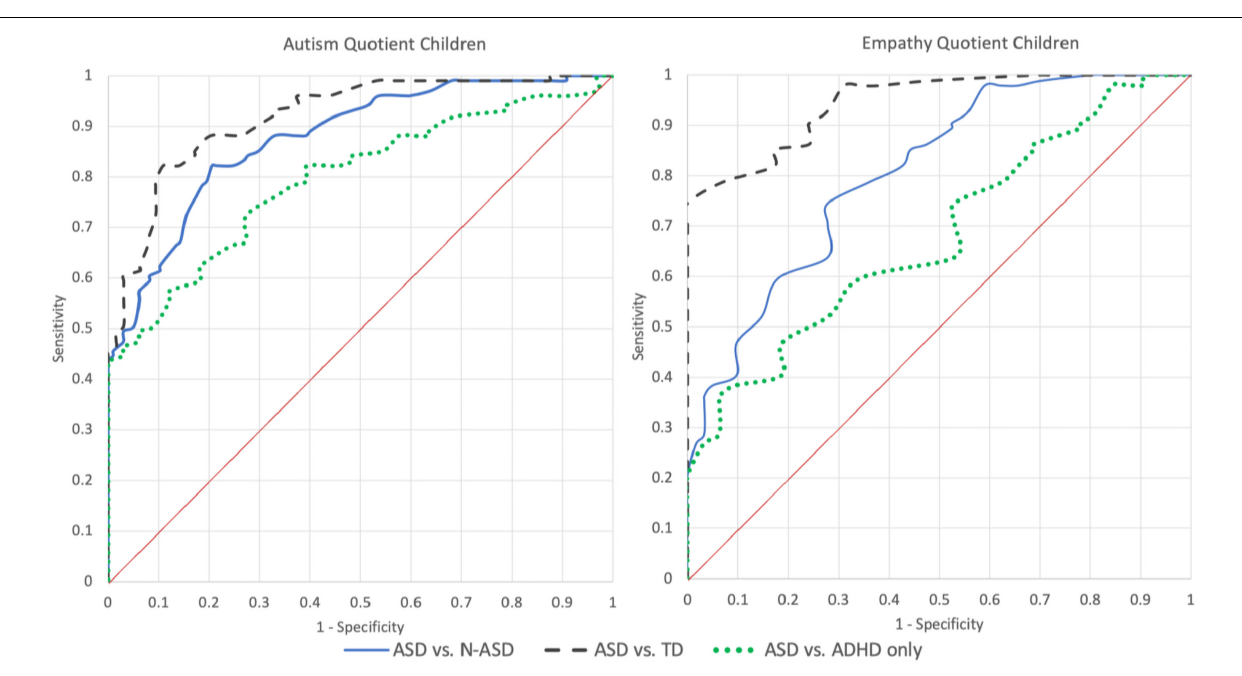
Frontiers in Neuroscience |